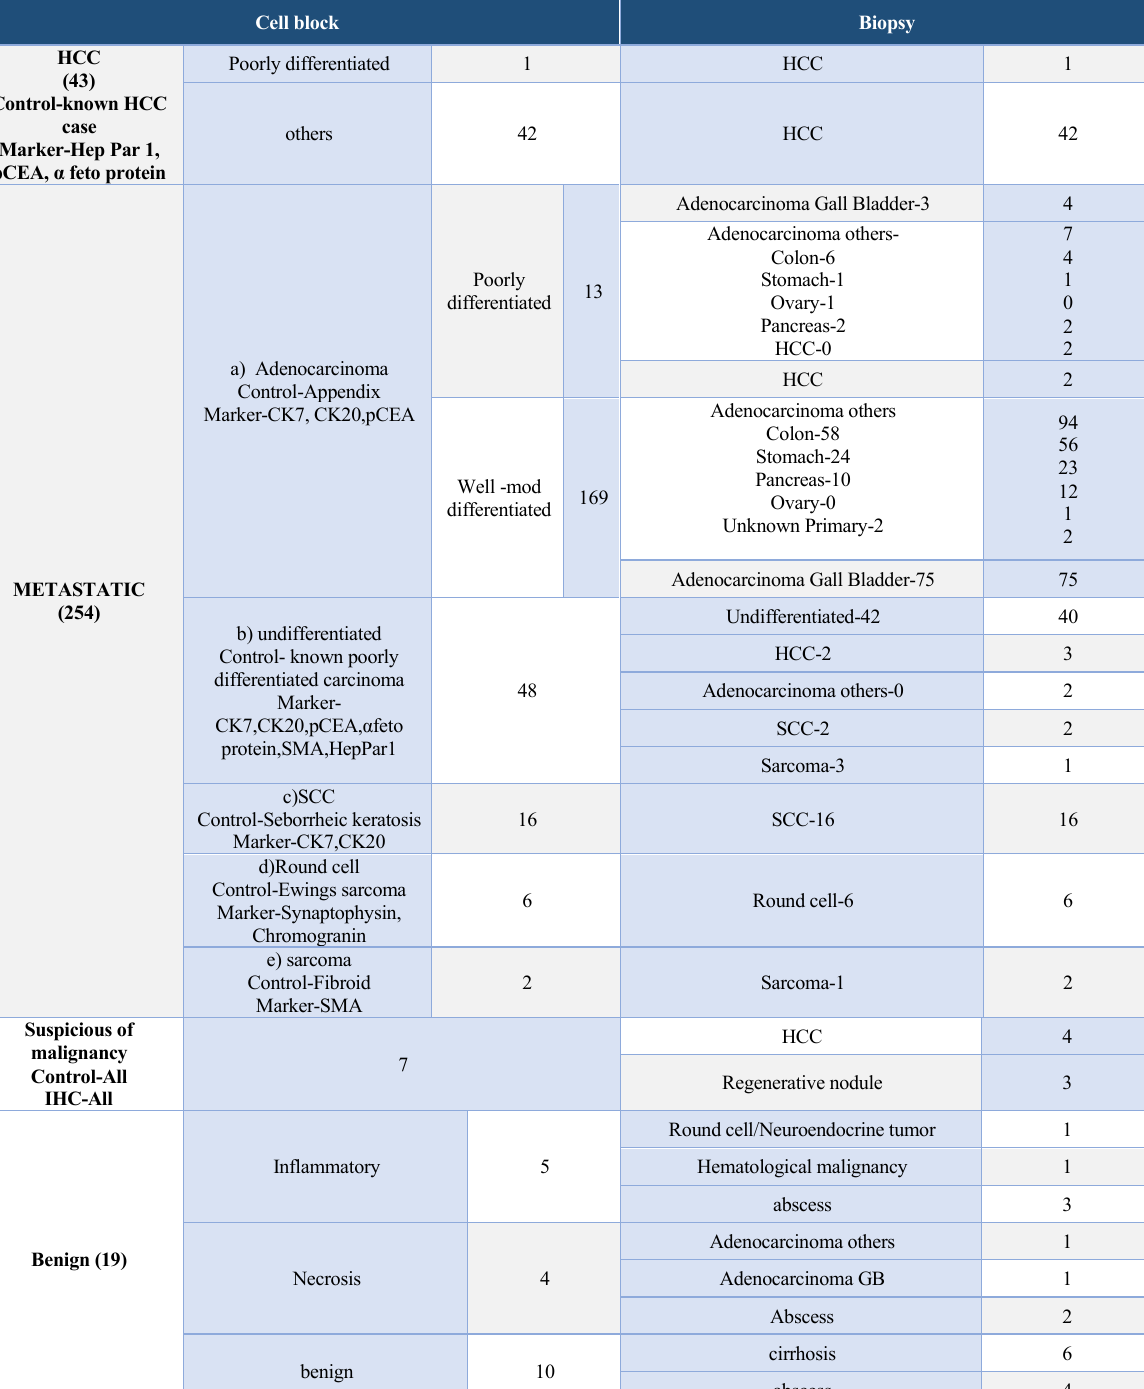
Table 1. Correlation of the cases in cell block with that of biopsy with immunohistochemical markers, control used and source of origin of